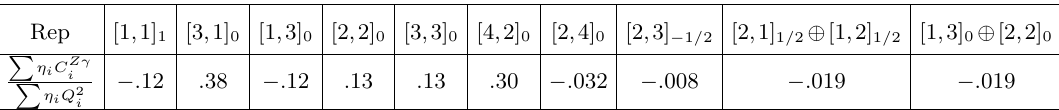
as a ratio to the contribution to κ Zγ